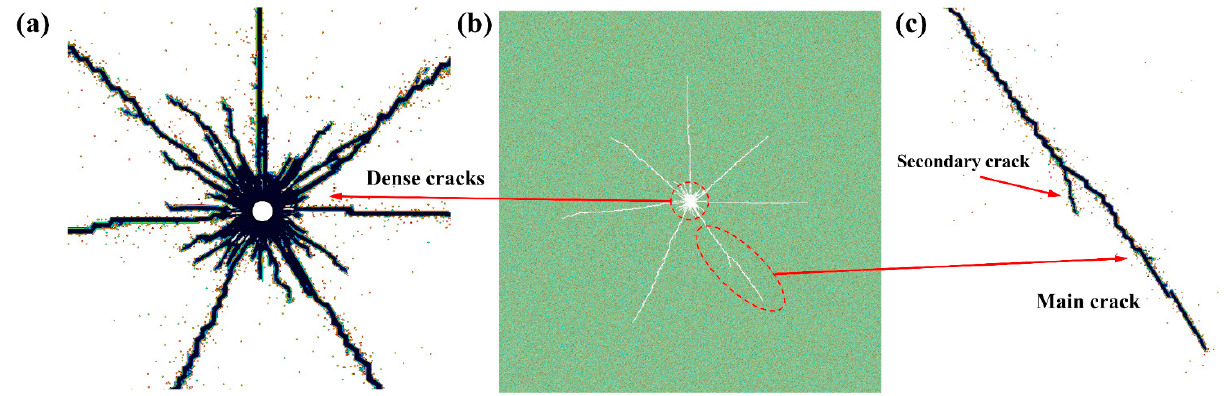
Figure 23. Distribution of cracks in granite under electropulse charge: ( a ) dense cracks near the electric channel hole, ( b ) final distribution of cracks, and ( c ) a main crack and a secondary crack.